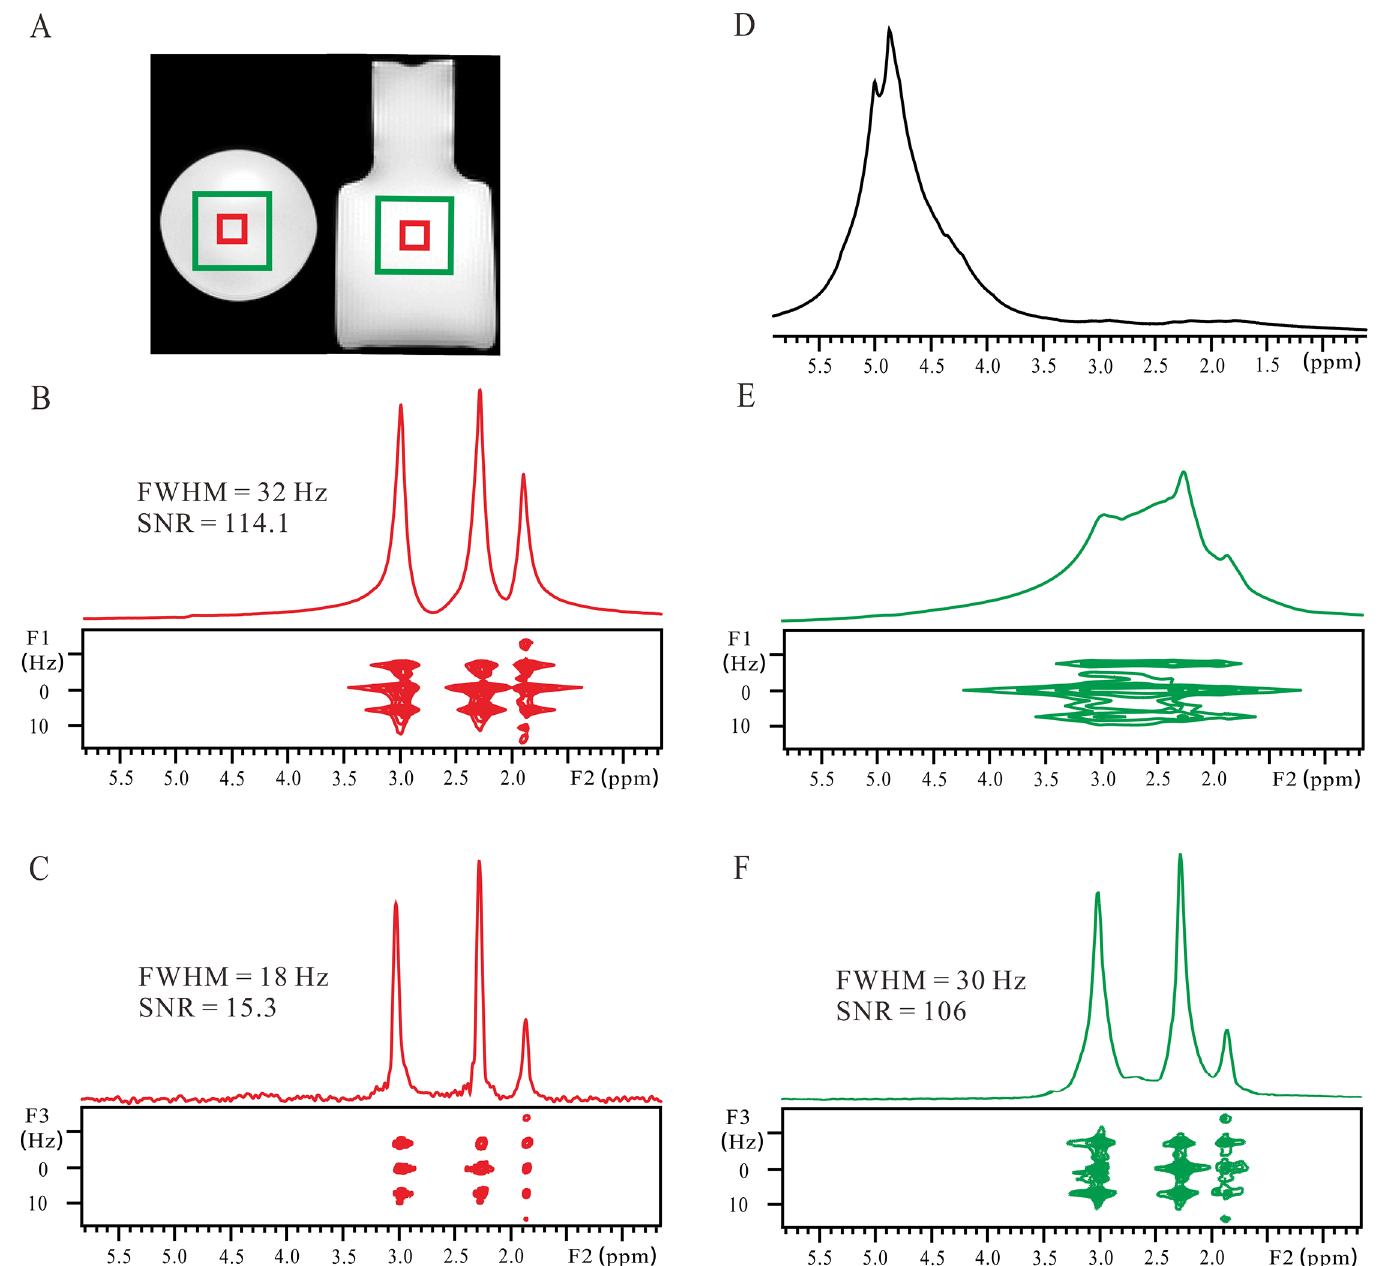
Fig 2. Results of the GABA aqueous solution. (A) Spin echo images of the GABA solution filled into a plastic bottle. A large voxel of 18 × 18 × 18 mm 3 is marked by a green rectangle, and a small voxel of 6 × 6 × 6 mm 3 is marked by a red rectangle. (B) Conventional 2D J PRESS spectrum after a clockwise rotation of 45° and its projection along the F2 axis acquired from the small voxel in a relatively homogeneous field after the field shimming procedure. (C) Localized iDQC J RES spectrum and its 1D J -decoupled projection along the F3 axis acquired from the small voxel under the same field homogeneity as (B). (D) Conventional 1D non-localized spectrum acquired in an inhomogeneous field with a 180 Hz FWHM of the water peak at 4.8 ppm. (E) Conventional 2D J PRESS spectrum after a clockwise rotation of 45° and its projection along the F2 axis acquired from the large voxel in an inhomogeneous field. (F) Localized iDQC J RES spectrum and its 1D J -decoupled projection along the F3 axis acquired from the large voxel in the same inhomogeneous field as